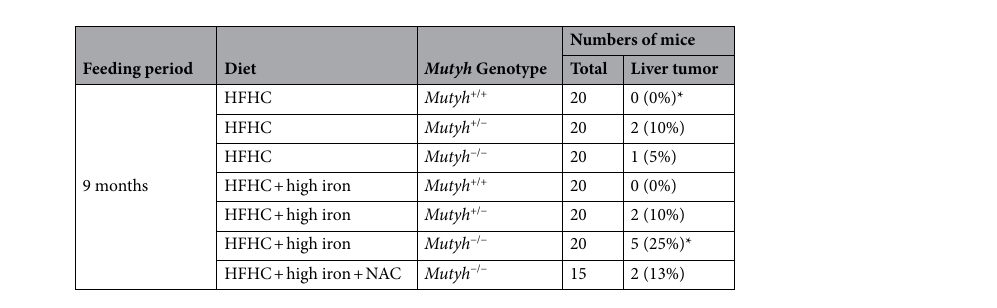
Table 1. Liver tumor incidence. *Chi-square test (HFHC + high iron diet Mutyh −/− group vs HFHC Mutyh +/+ group) P = 0.0168. HFHC, high-fat high-carbohydrate; NAC, N-acetyl L-cysteine.